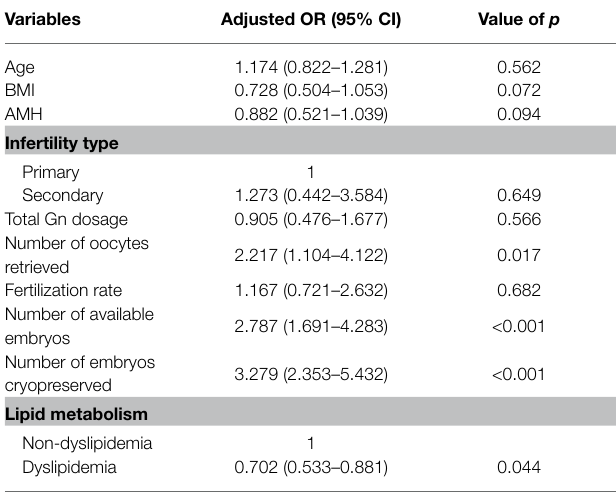
TABLE 5 | Outcomes of multivariate logistic analysis of the impact of dyslipidemia on cLBR.